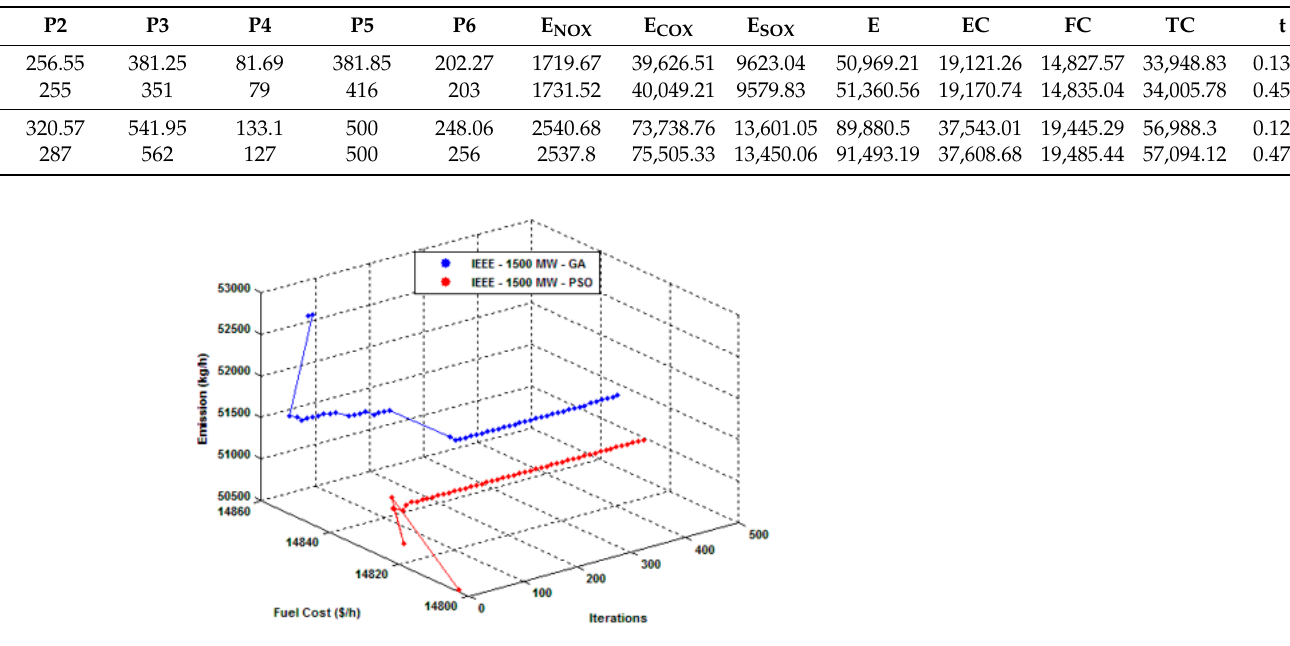
Table 3. The real-time simulation results of PSO and GA for IEEE 30 bus system with P D = 1500 MW and P D = 2000 MW.